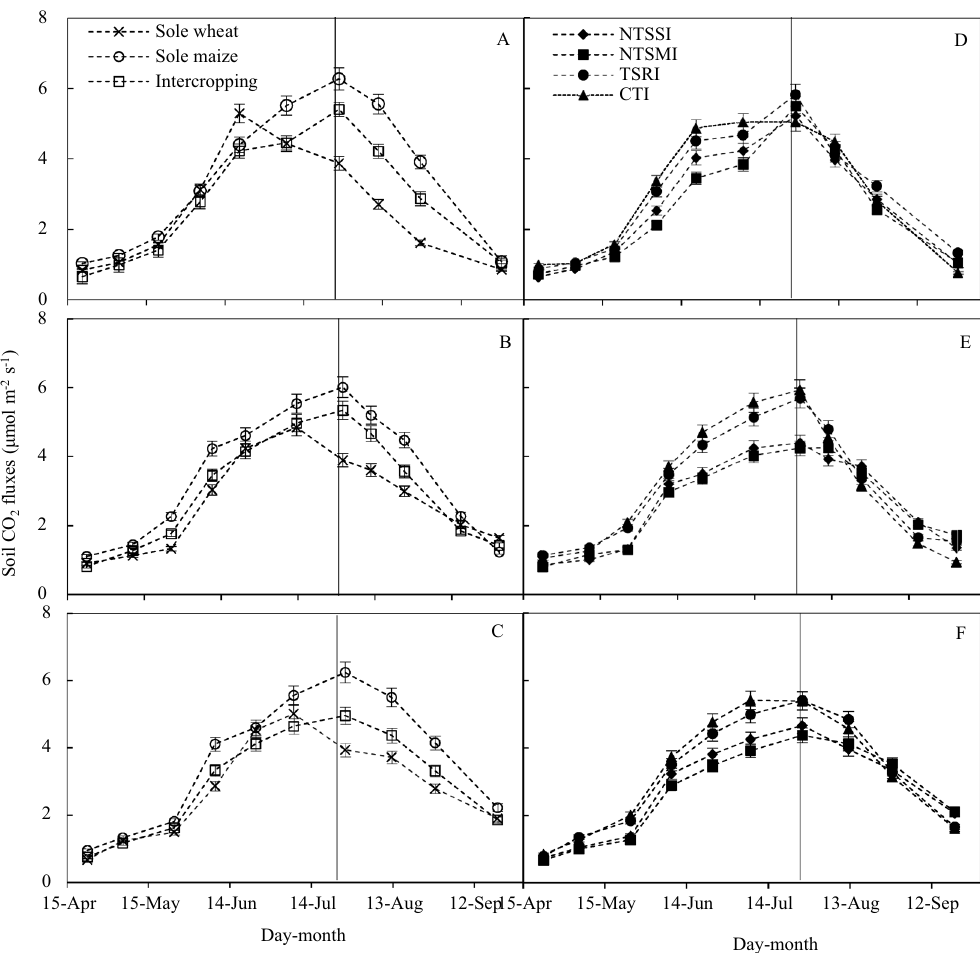
Figure 2. Seasonal variation of soil CO 2 fluxes by cropping pattern, across treatments within a given cropping pattern ( A – C ), and straw management and film mulching treatment within wheat–maize intercropping ( D – F ) in 2014 ( A , D ), 2015 ( B , E ), and 2016 ( C , F ). Descriptions of treatment abbreviations are in Table 4. Error bars indicate standard errors of the means (n = 3). The vertical line in the middle part of each figure shows the date of wheat